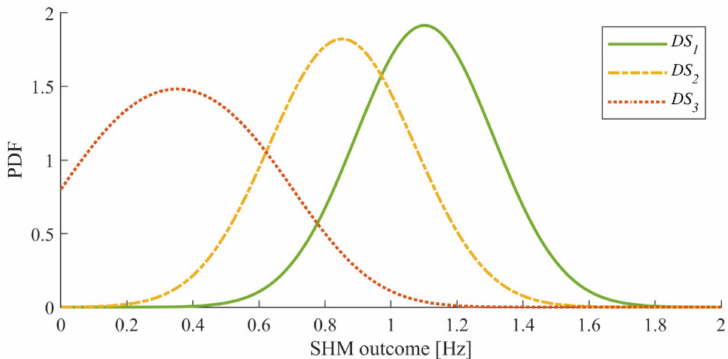
Figure 1. Likelihood functions for scoured